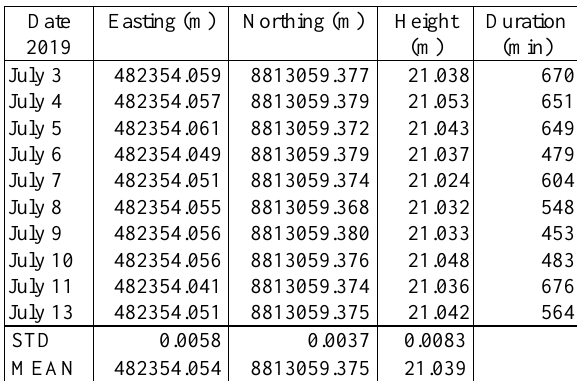
Table 2. Daily PPP solution for the base station antenna phase centre over the data from 3 rd through 13 th of July